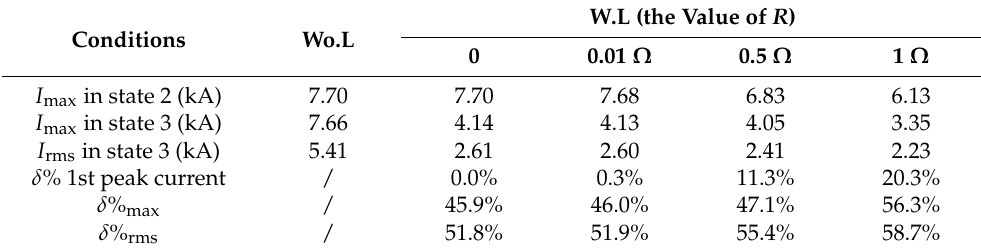
Table 2. Current value and current-limiting rate under different conditions.